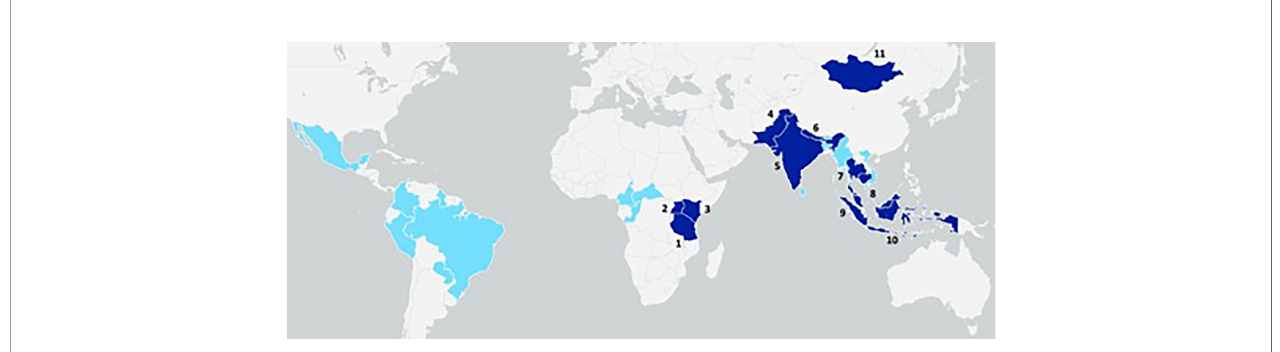
FIGURE 1 | Countries in the overall ranger perception survey (light blue) and countries that were included in this study as they relate to responses from at least 50 local and 50 non-local rangers (dark blue). (1) Tanzania, (2) Uganda, (3) Kenya, (4) Pakistan, (5) India, (6) Nepal, (7) Thailand, (8) Cambodia, (9) Malaysia, (10) Indonesia, (11)